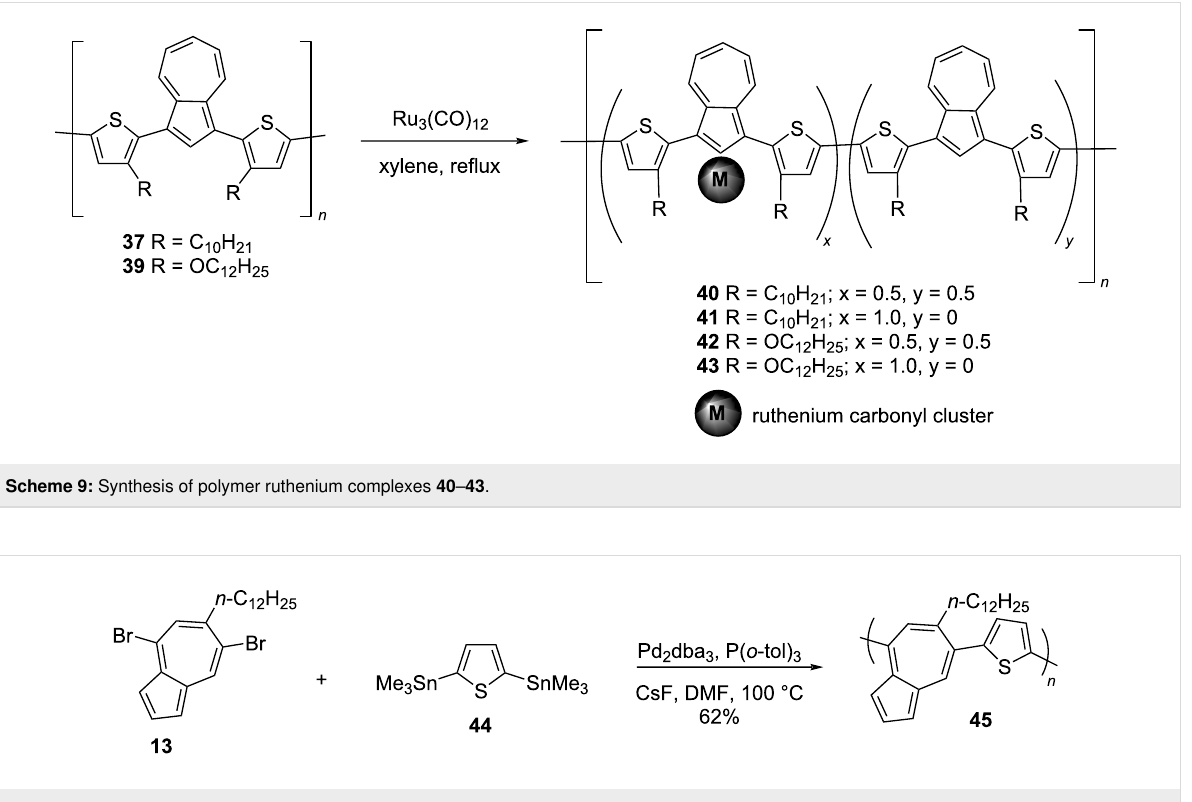
Scheme 10: Synthesis of 4,7-polyazulenes 45 containing a thienyl